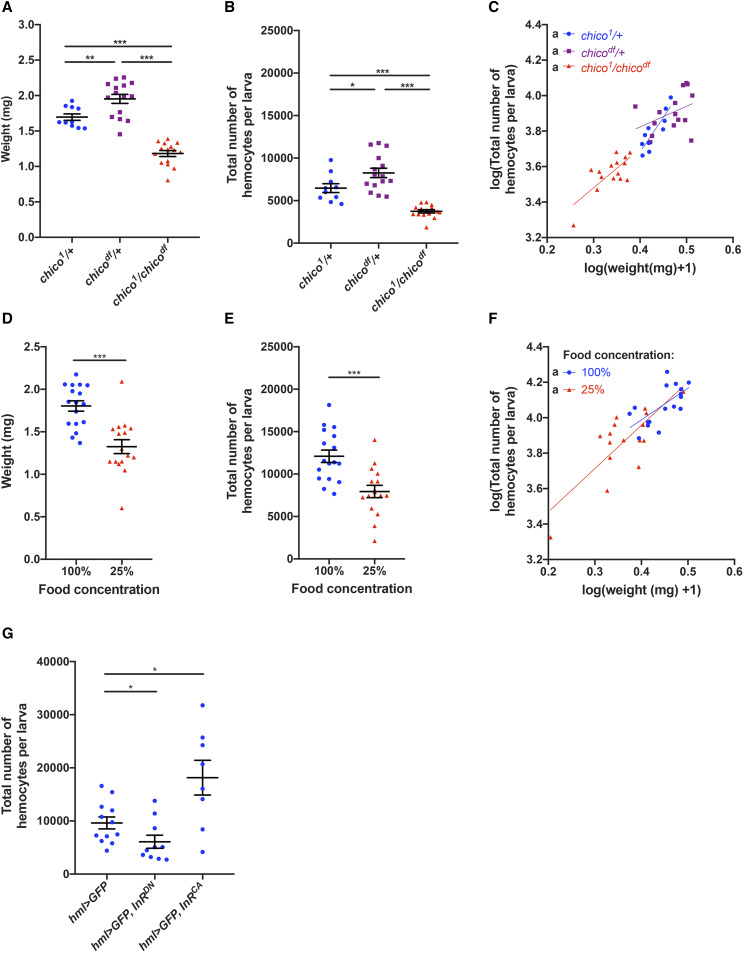
Insulin-like signaling in hemocytes links nutrient-dependent larval growth to hemocyte number. (A) chico1/chicodf larvae are significantly smaller than both heterozygous controls (P < 0.001, n ≥ 10) at the wandering stage. (B) Wandering chico1/chicodf larvae have significant fewer hemocytes than both heterozygous controls (hmlΔ-GAL4 > UAS-GFP, P < 0.001, n ≥ 10). (C) Data in (B) incorporating larval weights shows that wandering chico1/chicodf larvae have fewer hemocytes than their heterozygous counterparts because of their reduced weight. (D) Larvae raised on a diluted diet (25%) were significantly smaller than larvae raised on the standard 100% diet (P < 0.001, n ≥ 16) at the wandering stage. (E) Wandering larvae raised on a 25% diet had significantly fewer hemocytes than fully fed controls (hmlΔ-dsRed, P < 0.001). (F) Combining data in (D, E) shows that wandering larvae raised on the 25% diet have fewer hemocytes than those on the 100% diet because of their reduced weight. (G) Quantification of total hemocyte number (hml-GAL4 > UAS-GFP) in wandering stage larvae expressing either InRDN or InRCA in hemocytes throughout larval development. Expression of InRDN resulted in a reduction in total hemocyte number (P = 0.030), while expression of InRCA resulted in an increase (P = 0.039, n ≥ 8). For (B, E) regression lines that cannot be represented by the same line of best fit are indicated by different lowercase letters. NS, not significant, *P < 0.05, **P < 0.01, ***P < 0.001, Mann-Whitney test. Data points are individual larvae with means ± 1 SE indicated.